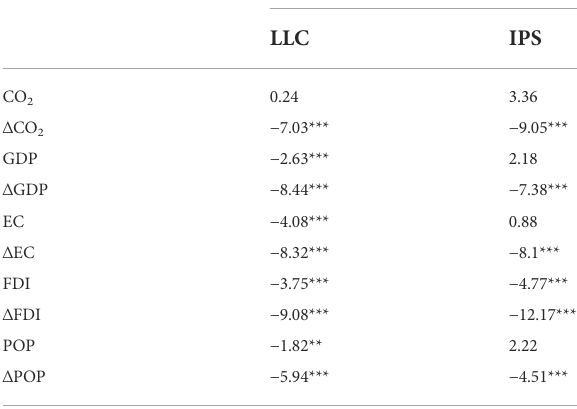
TABLE 3 Results of unit root tests.